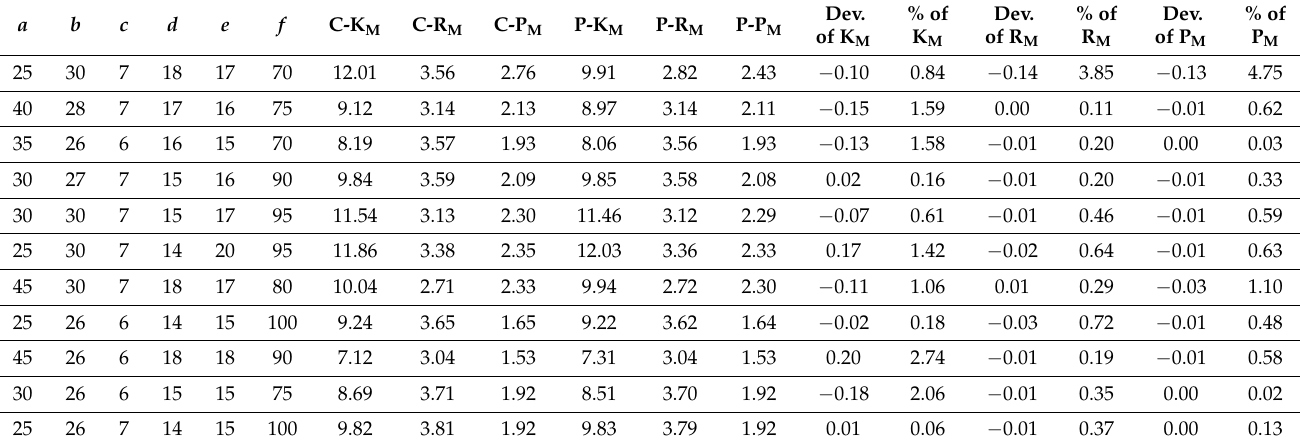
Table 11. Testing and comparing the prediction and calculation results for MIG welding process.